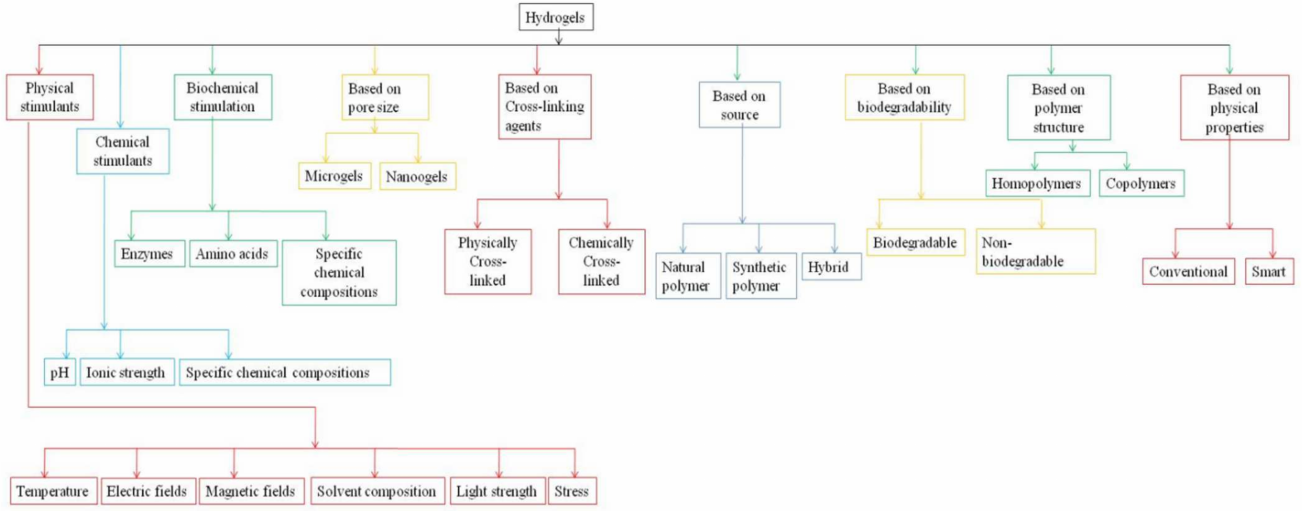
Figure 1. Classification of